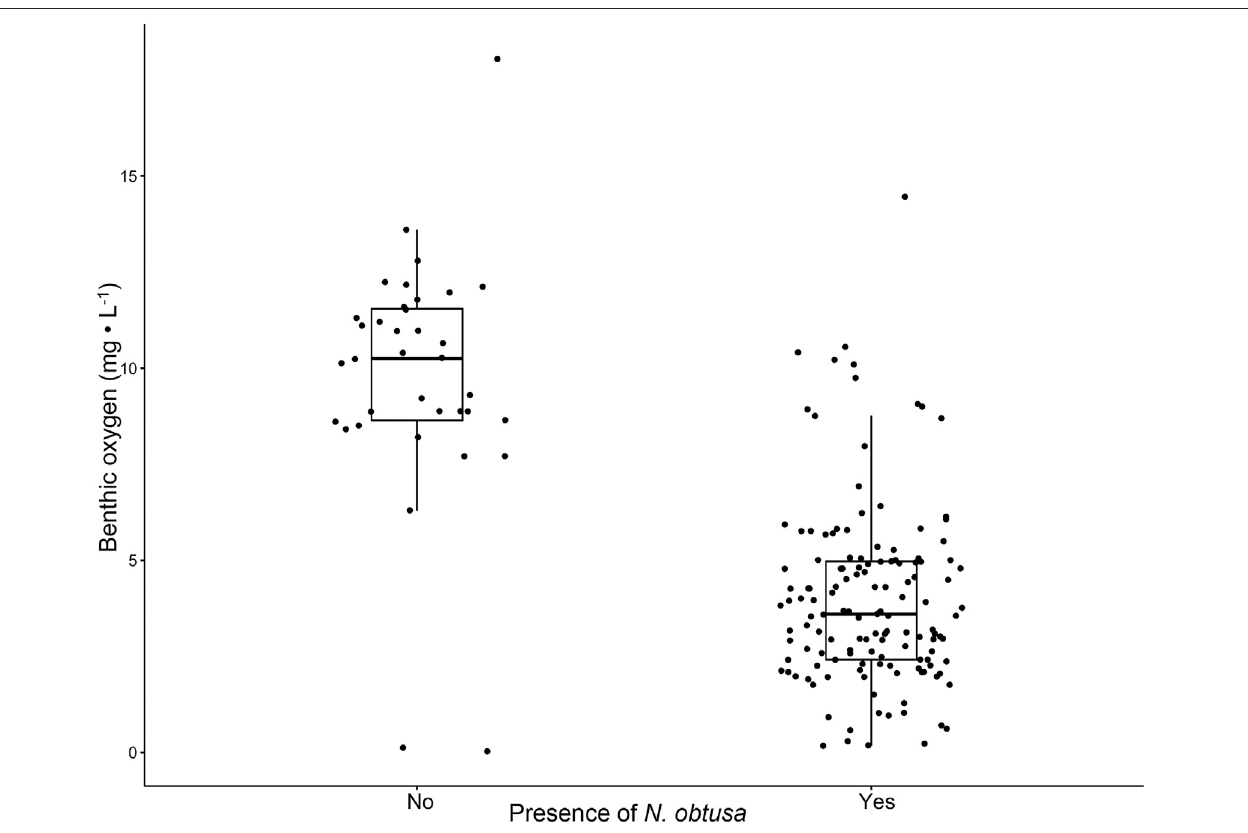
FIGURE 3 | Boxplots comparing benthic oxygen concentrations for sites with ( n (cid:1) 138) and without ( n (cid:1) 36) N. obtusa presence. A Welch ’ s t -test was used to compare sample means ( α (cid:1) 0.05).